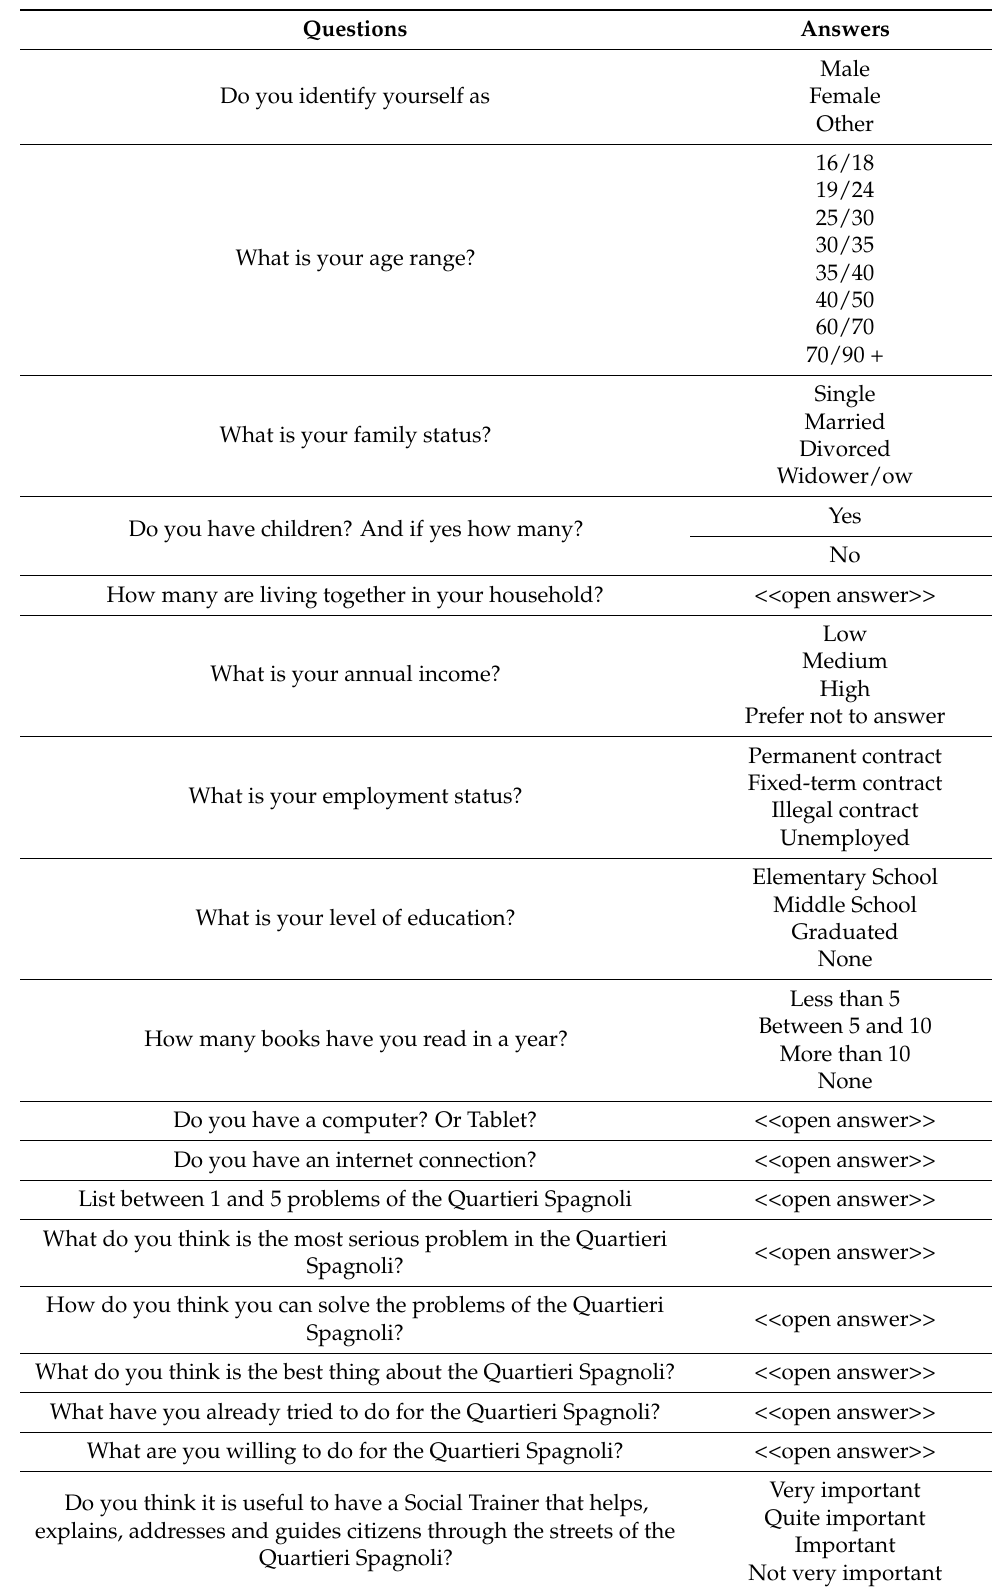
Table 1. Questionnaire developed by Filosofia Fuori le Mura for the AGOGH È